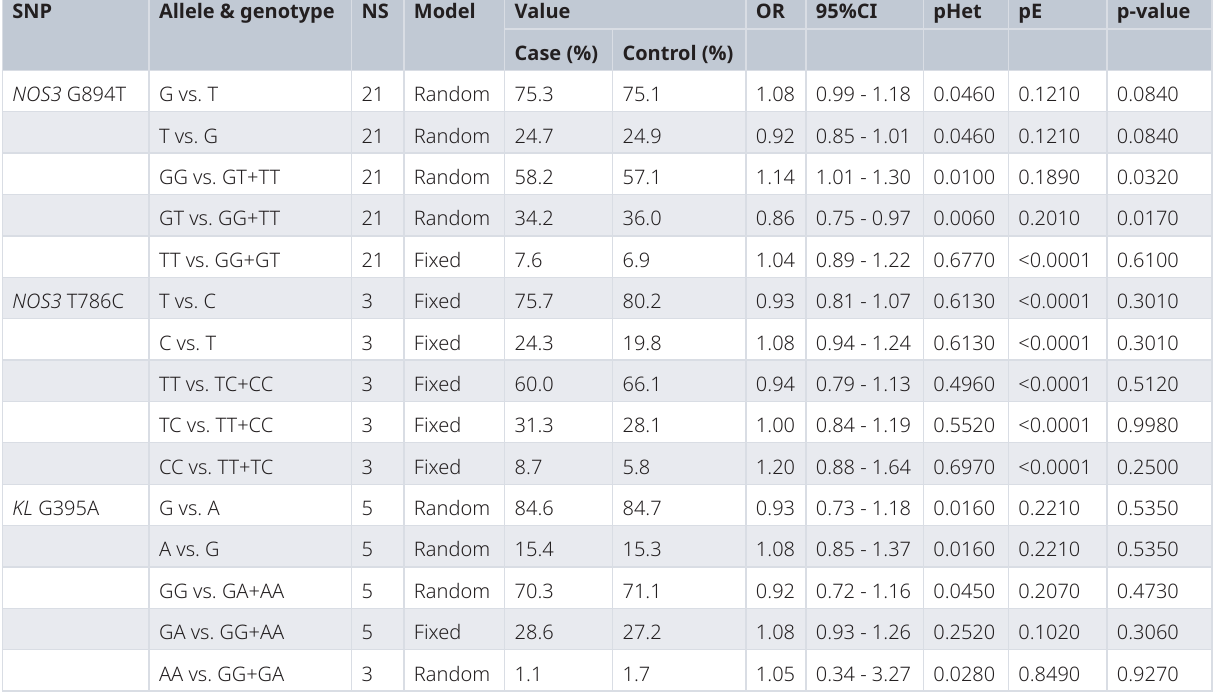
Table 1. Summary of the association between the risk of age-related cognitive impairment and both NOS3 and KL gene polymorphisms. SNP Allele &